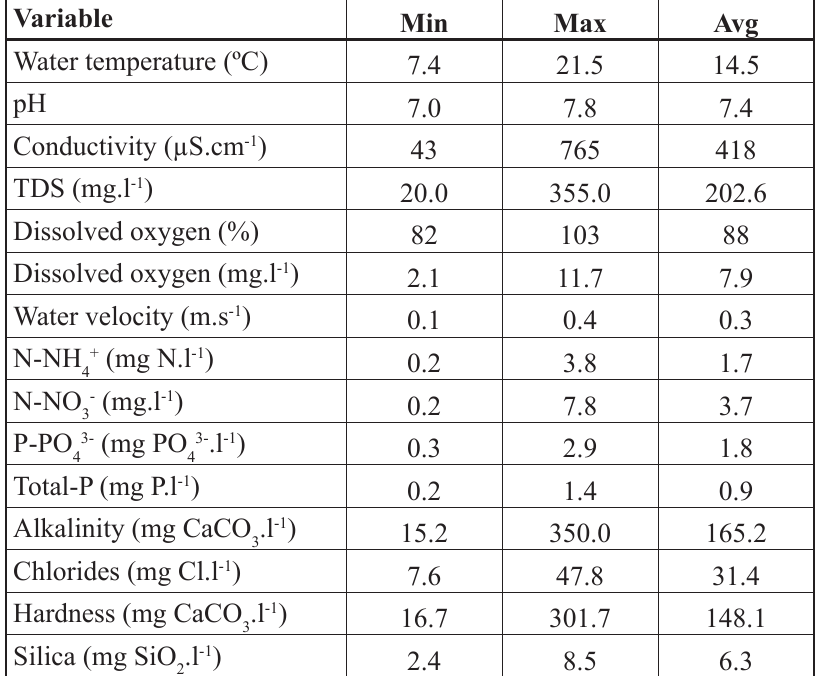
Table 1. Minimum (Min), maximum (Max) and averages (Avg) of 14 physical and chemical variables and water velocity (n = 8 samples) corresponding to the ecological spectrum of the presence of Fragilaria rinoi Almeida & C.Delgado sp. nov. in